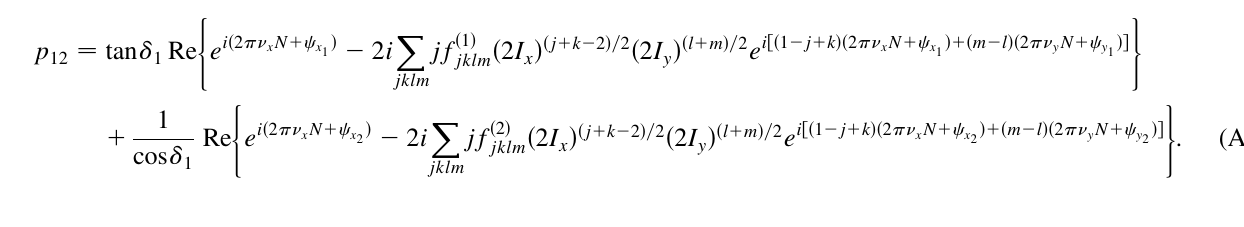
FIG. 5. (Color) Measurement of j (cid:25) bottom plot shows the sextupolar components of the ring.